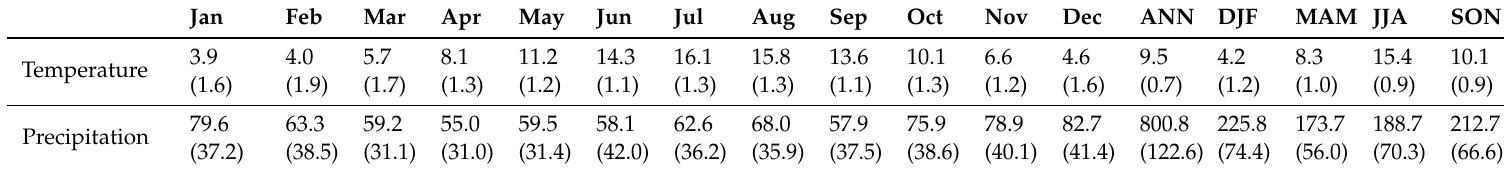
Table 3. The monthly, seasonal and annual mean temperature and precipitation total for the weather station at WP, 1883–2015 (standard deviation in brackets).